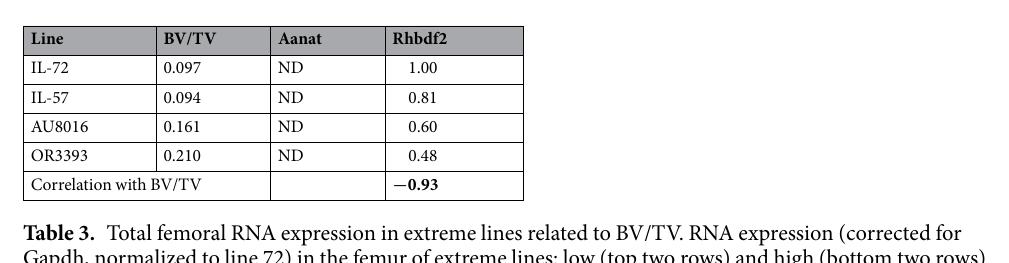
Table 3. Total femoral RNA expression in extreme lines related to BV/TV. RNA expression (corrected for Gapdh, normalized to line 72) in the femur of extreme lines: low (top two rows) and high (bottom two rows) BV/TV. Note the negative meaningful correlation of Rhbdf2 with BV/TV and the undetectable expression levels of Aanat